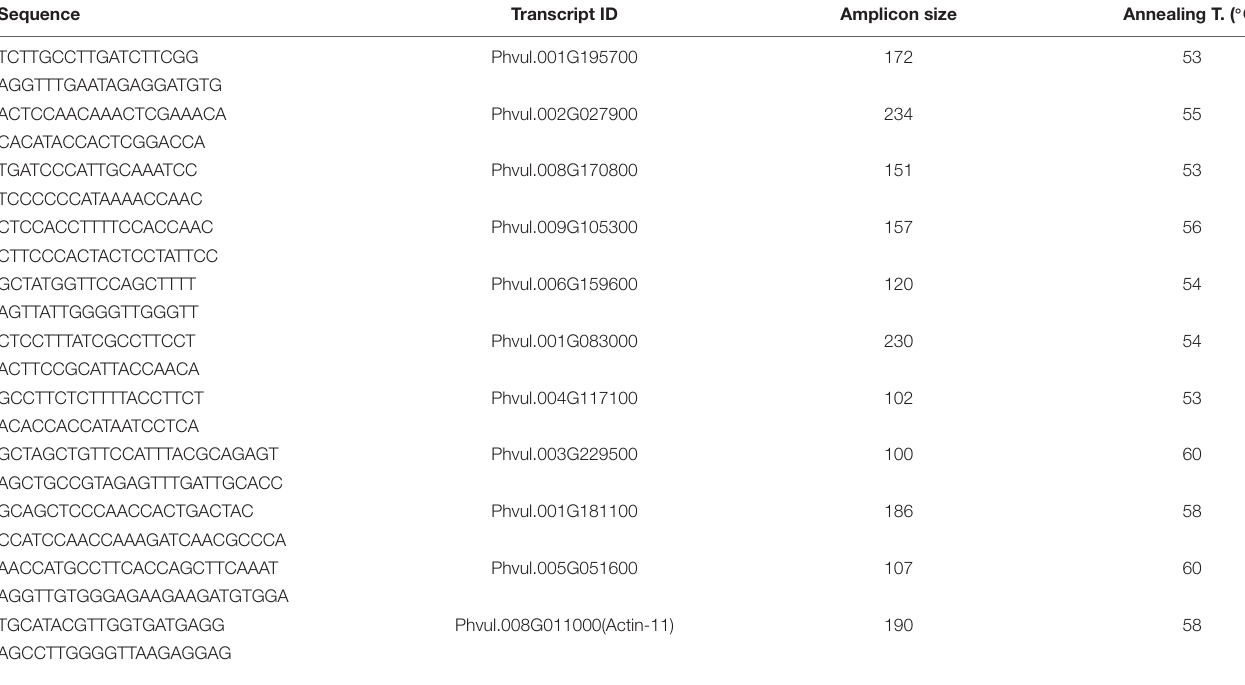
TABLE 1 | qRT-PCR primers used for RNA-seq validation.